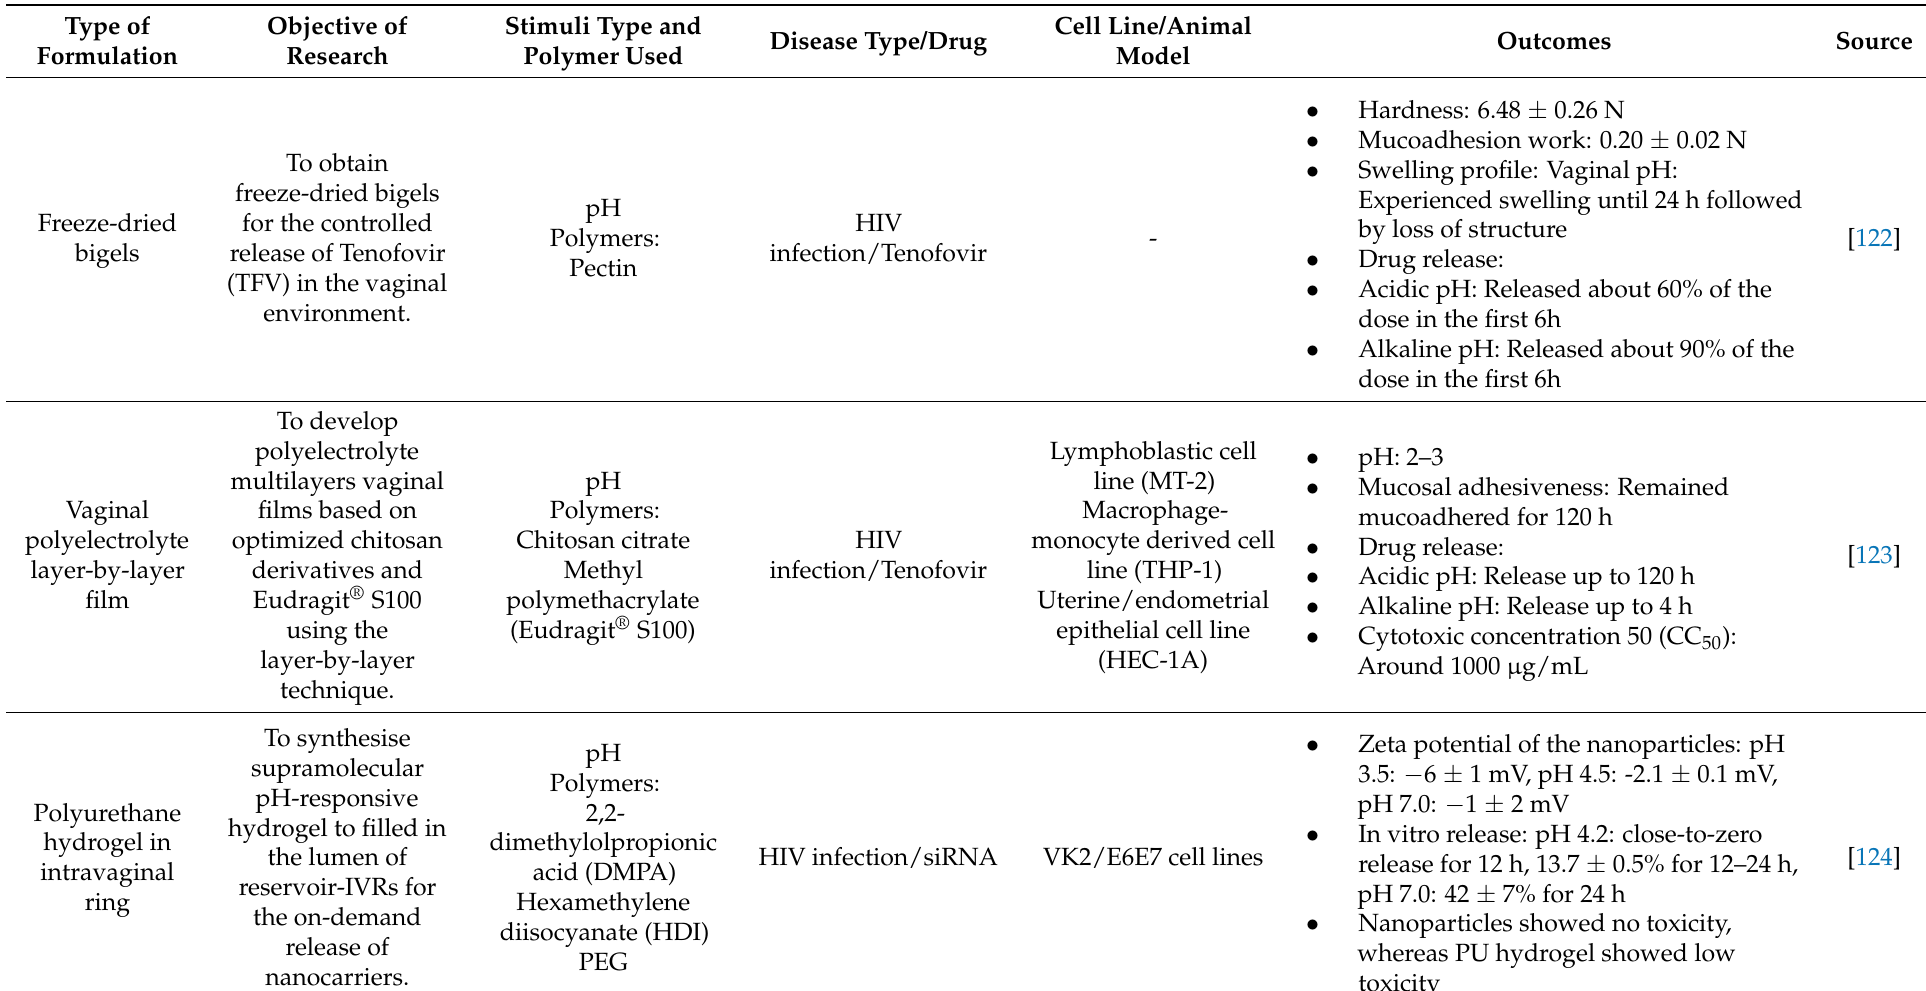
Table 4. pH-responsive systems for vaginal drug